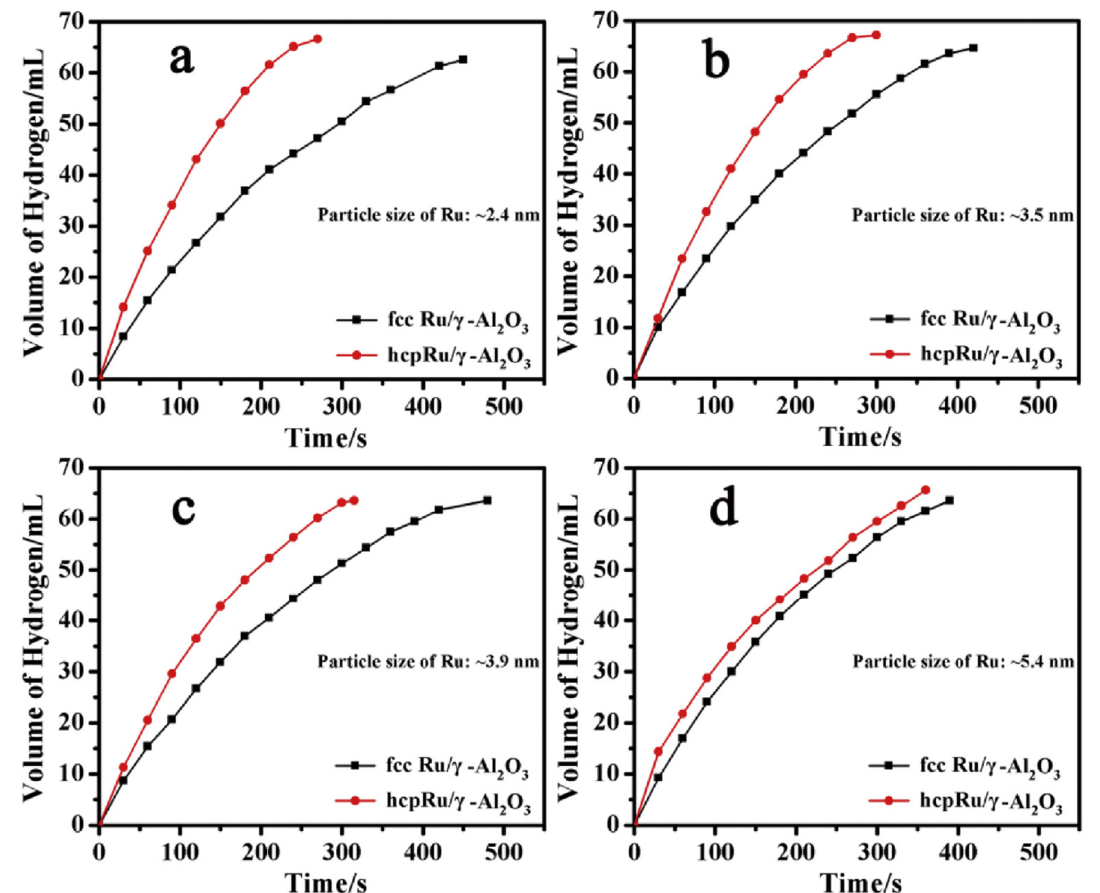
Figure 5. The plot of H 2 volume (mL) versus time (s) graph for the dehydrogenation of AB (n AB = 1 mmol) catalyzed by the Ru with different crystal phase (fcc: face-centered cubic; hcp: hexagonal close-packed) for different particle sizes : ( a ) ~2.4 nm, ( b ) ~3.5 nm, ( c ) ~3.9 nm, ( d ) ~5.4 nm. Experimental conditions: 25 °C and n Ru /n AB = 0.003. Adapted from [102].